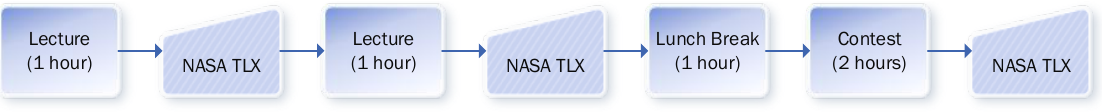
Figure 8. The daily schedule and data collection procedure during the algorithmic programming